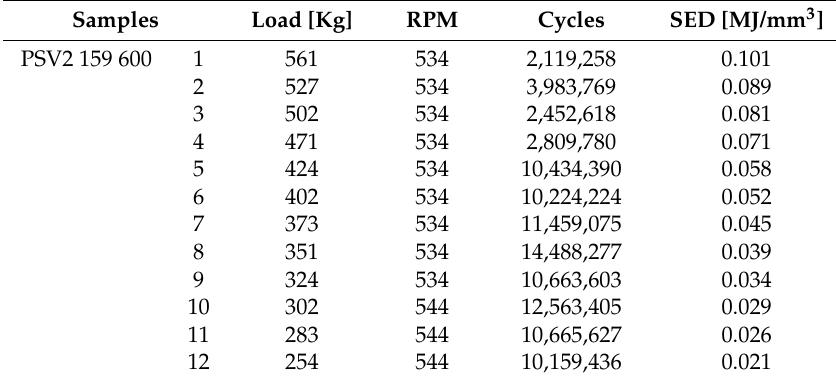
Table 5. Fatigue data for the roller PSV2 159 600.